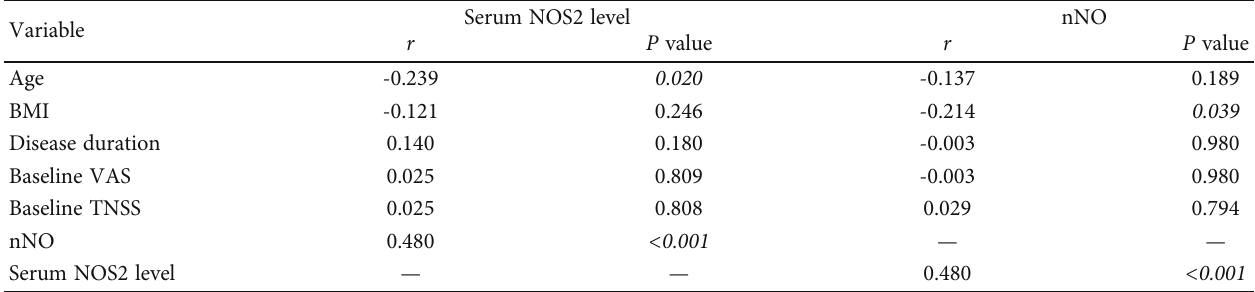
Table 3: Association between serum NOS2, nNO, and clinical variables in AR patients.